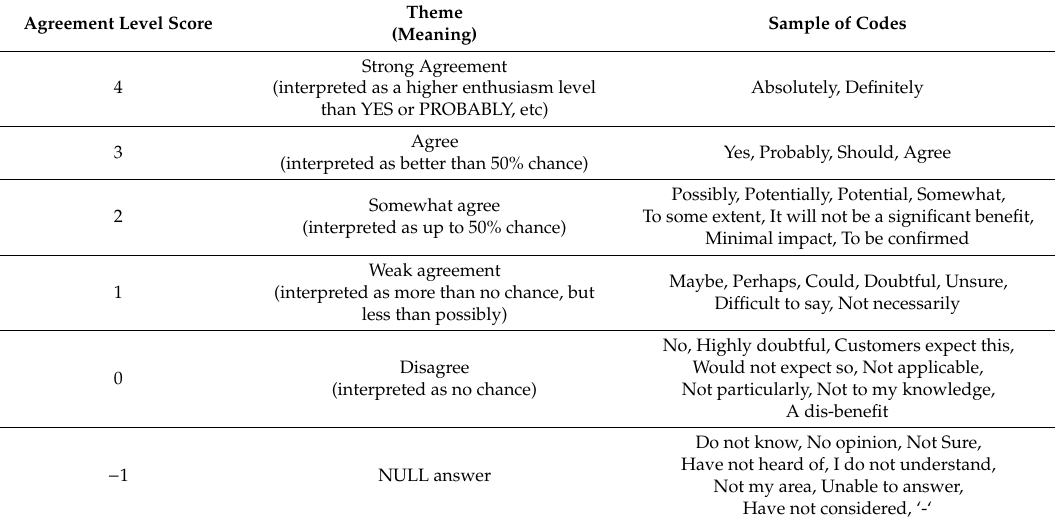
Table 4. Coding keywords for agreement level scoring from expert assessments.